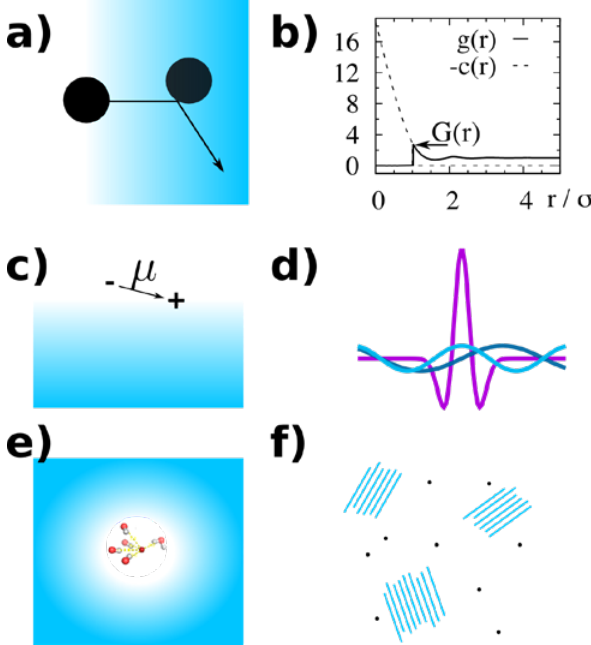
Figure 4. Hybrid discrete/continuum theories. (a) Boltzmann pic- ture of scattering by one particle chosen ‘at random’ from the con- tinuum. (b) Mean spherical approximation for the hard sphere fluid of diameter σ. g ( r ) and c ( r ) are known at r << σ and r >> σ, but the central region is a guess. (c) Sommerfield conception of a dipole above a continuous polarizable medium. (d) Bohm-Pines concep- tion of a quasiparticle (purple, central peak) and two long-range plasmons (blue). (e) Dressed ion, quasichemical, or Lorenz- Lor- entz-Mossotti-Clausius 51 cavity models of a discrete molecule in a continuum solvent, (f) significant / inherent structure theory of a coexisting mixture of ordered and disordered regions making up an overall homogeneous